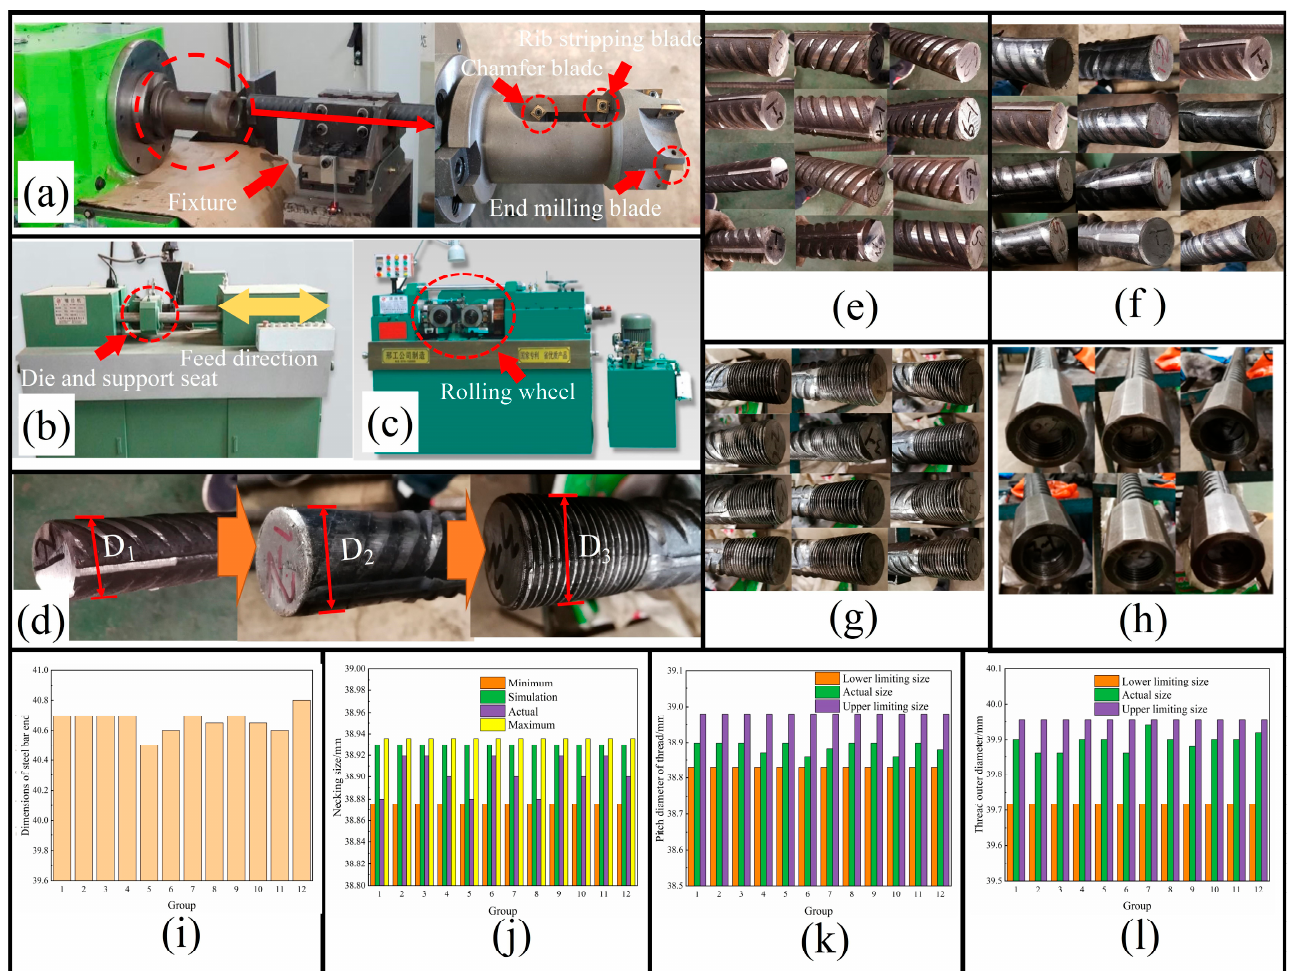
Figure 3. Experimental process. ( a ) Rib stripping and chamfering equipment. ( b ) Necking formation machine. ( c ) Thread rolling machine. ( d ) Diameter to be measured. (D1—Dimensions of steel bar end after stripping ribs. D2—Dimensions changes after necking formation. D3—Thread outer diameter after rolling.) ( e ) Experimental results of workpieces by composite cutting tool. ( f ) Experimental results of workpieces after necking formation. ( g ) Experimental results of workpieces after thread rolling formation. ( h ) Experimental results of workpieces for screw-in test. ( i ) Dimensions of steel bar end after stripping ribs. ( j ) Dimension changes after necking formation. ( k ) Changes of pitch diameter of rolled thread. ( l ) Changes of thread outer diameter after rolling.